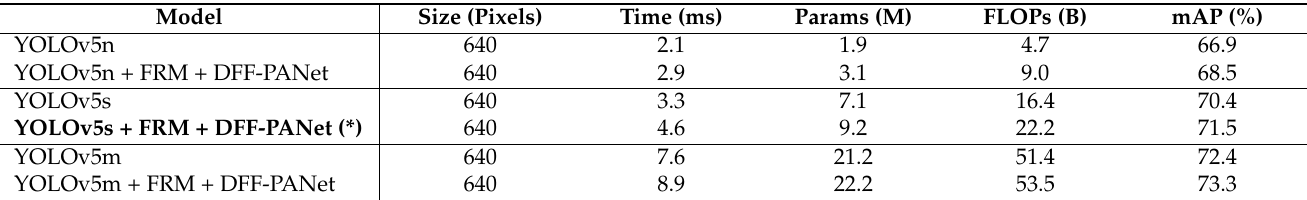
Table 9. Experimental results of different models on the DOTA dataset (* represents the model proposed in this